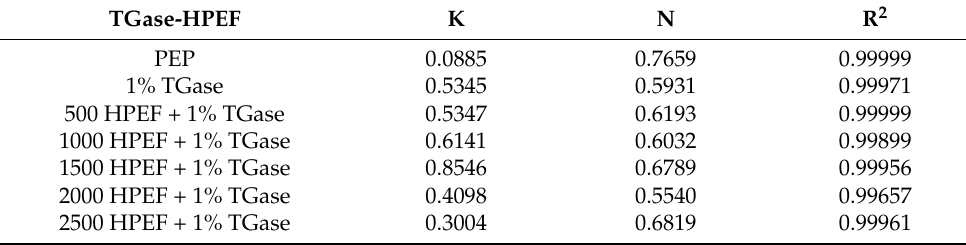
Table 4. The power-law model of PEP under the preconditioning of compound treatment (HPEF-500, 1000, 1500, 2000, 2500 V/cm; 1%